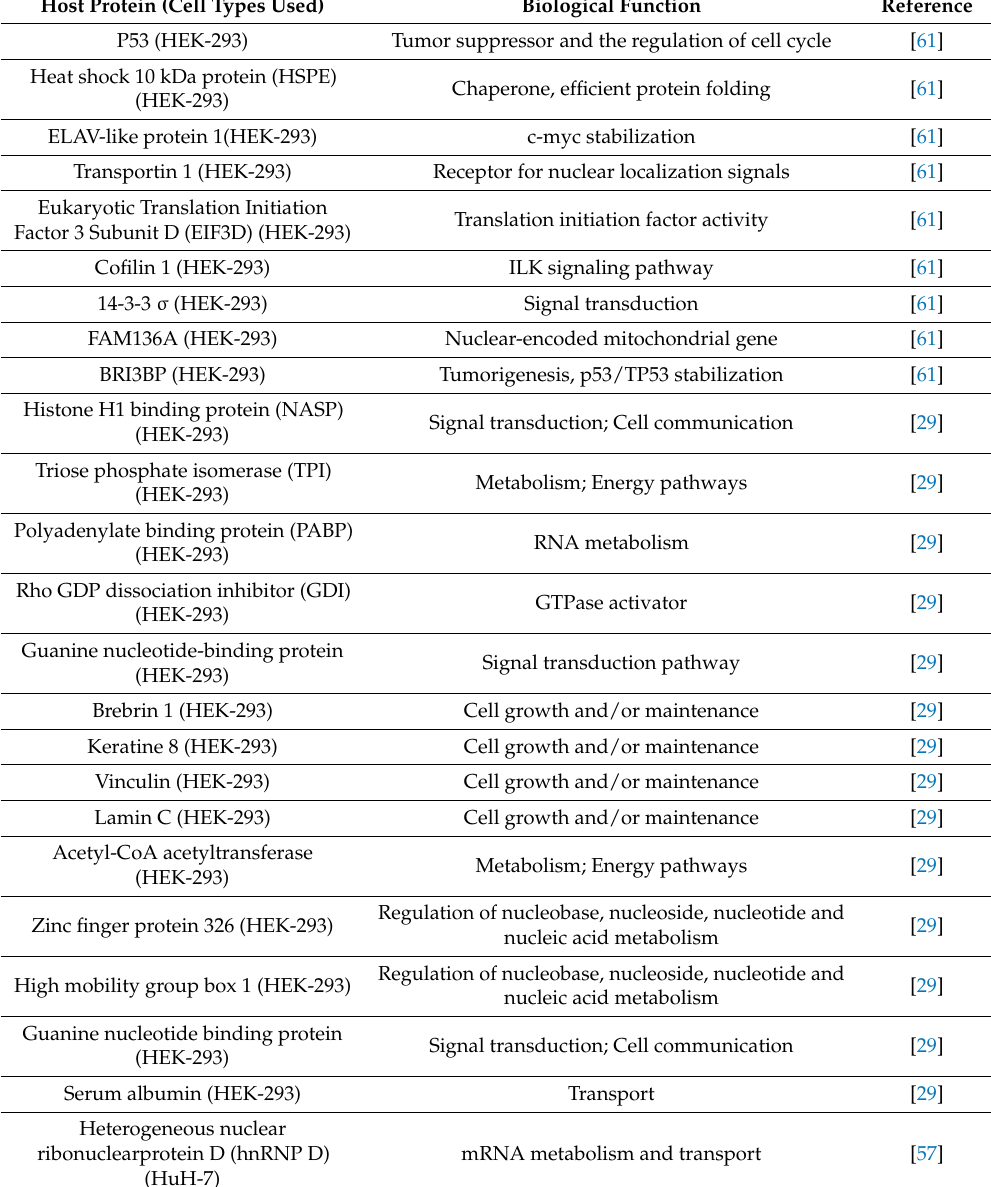
Table 2. List of host protein differentially expressed in the presence of HDV RNA and/or